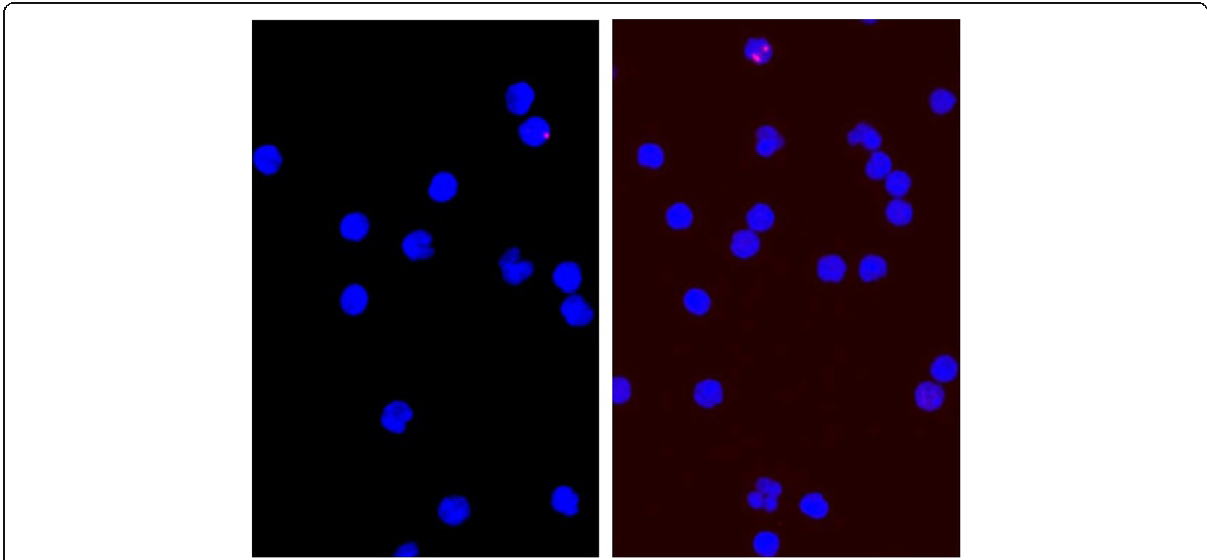
Fig. 3 Typical fluorescent microscopy images of lymphocyte nuclei stained in blue showing a nucleus with one (left) and two (right) γ H2AX foci stained in red